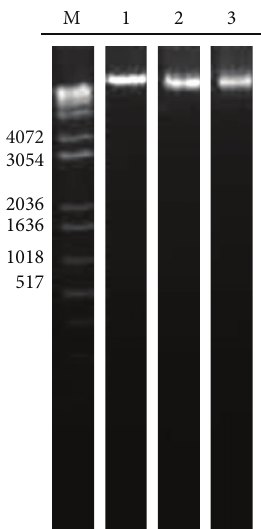
Figure 4: Genomic DNA of cells exposed to SeMet and SSe. M corresponds to the molecular markers (bp); controls (Lane 1); cells exposed to 0.5 mM Se as SeMet (Lane 2); cells exposed to 0.5 mM Se as SSe (Lane